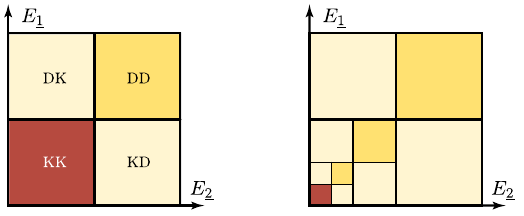
The following diagram schematically depicts the iterative refinement of KK sectors (red squares) leading to Eq. (56).